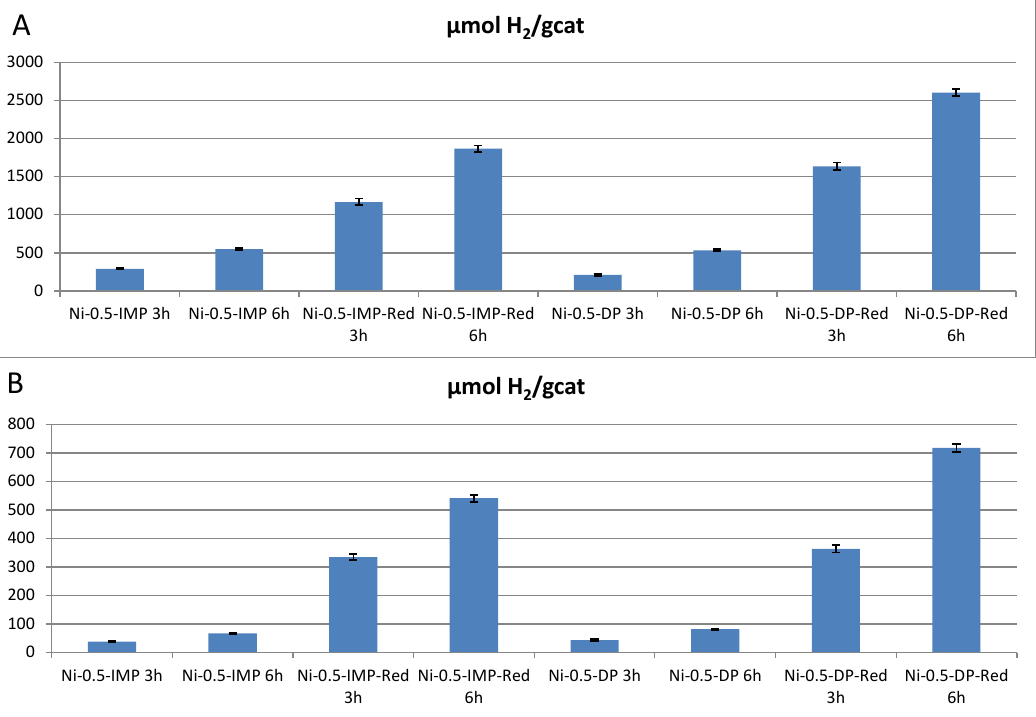
Figure 8. H 2 production via glycerol photo-reforming on untreated and pre-reduced solids using UV ( A ) and solar ( B ) irradiation.